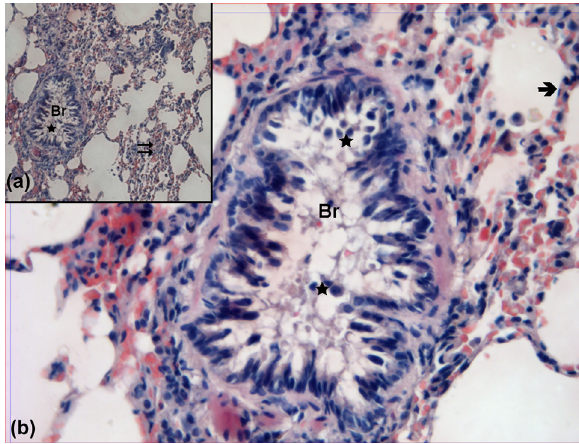
Figure 5: Hematoxylin – eosin - stained lung samples obtained from the group treated with remifentanil plus propofol. Br: bronchioles, (cid:2) : alveoli, (cid:3) : interalveolar septa, (cid:2) : cell debris ( hematoxylin – eosin, A: × 100, B: × 400 )